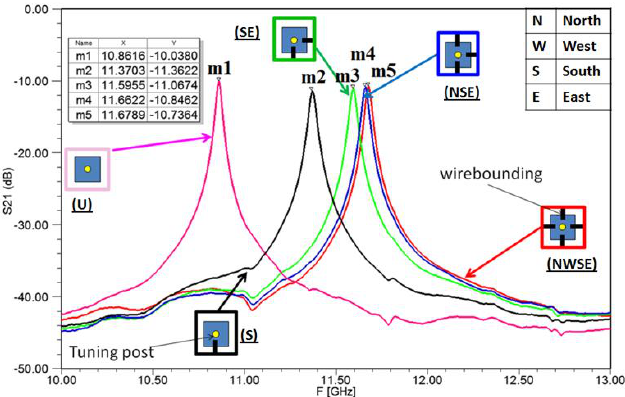
Figure 1. Photograph of a substrate integrated waveguide (SIW) cavity with tuning post and four wire bondings.